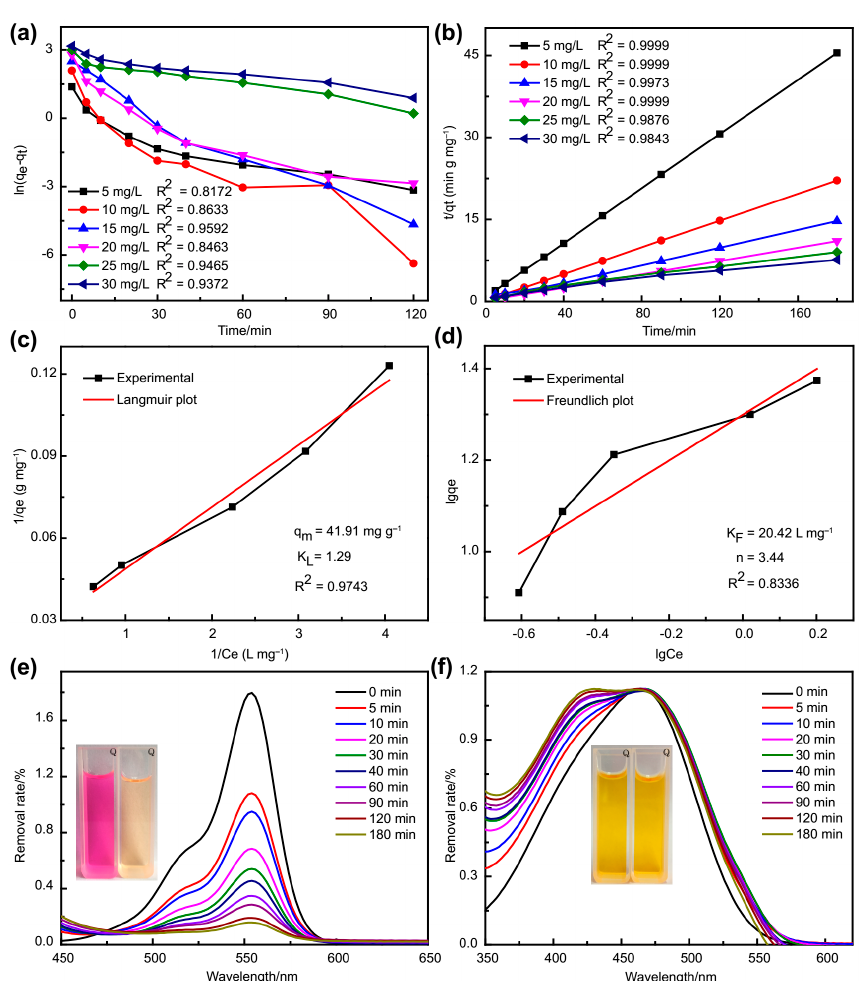
Figure 10. Plots for ( a ) pseudo-first-order, ( b ) pseudo-second-order, ( c ) Langmuir and ( d ) Freundlich isotherm model for the adsorption of MB onto Fe 3 O 4 @ 1 . The adsorption spectra of ( e ) RhB and ( f ) MO by Fe 3 O 4 @ 1 .